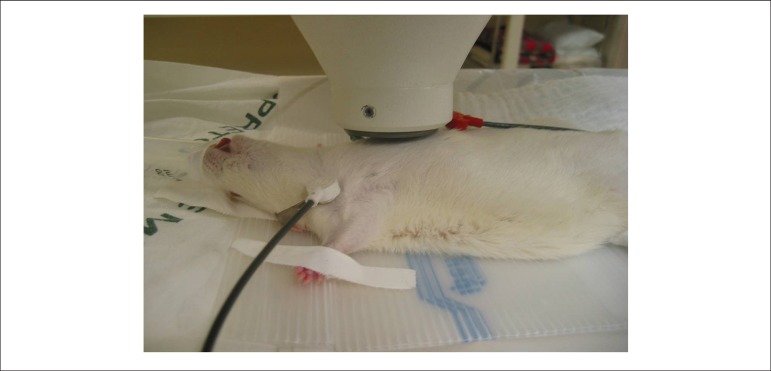
Positioning of the animal and the electrodes for radionuclide
ventriculography.